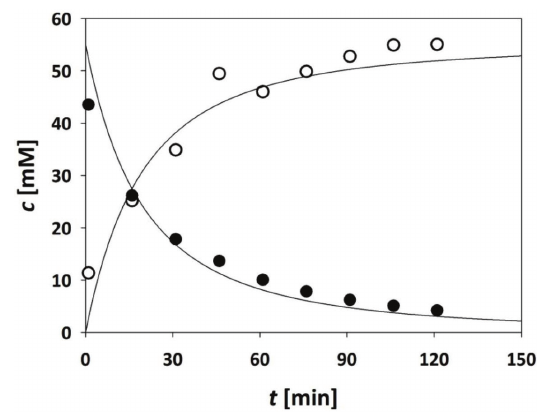
Fig. 4 – Spontaneous hydrolysis of glucono-δ-lactone (0.1 M phosphate buffer pH 7, 30 °C). Black circles – glucono-δ-lac- tone, white circles – gluconic acid, line–model.